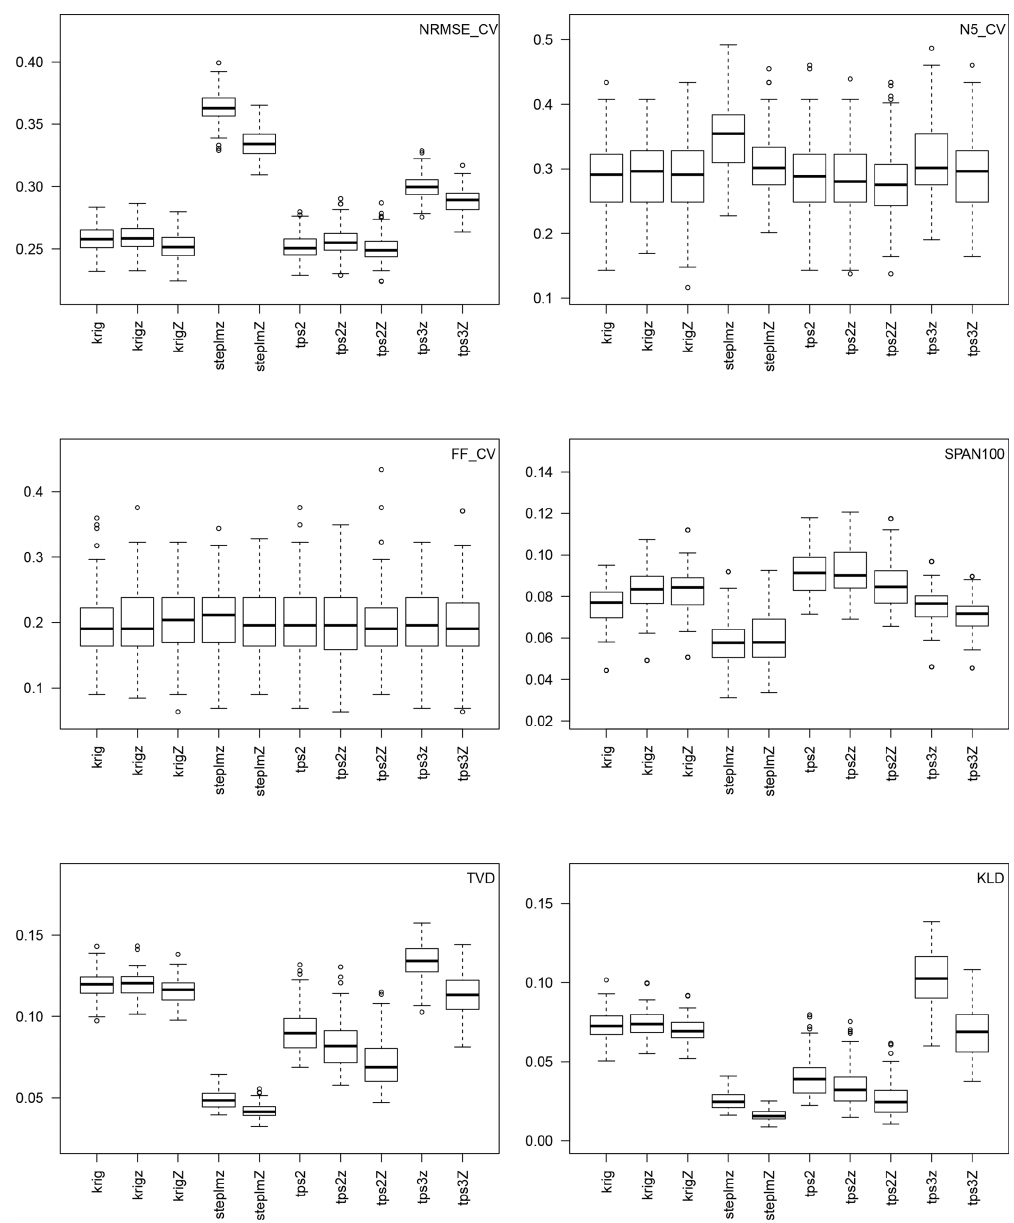
Figure 10. Scores of mapping when G s,k are Gamma distributions with S = 2 and K = 3 whose parameters are interpolated with the mapping models of Table 3. The first two rows show leave-one-out cross-validation scores. Each boxplot contains 200 points. The third row compares interpolations at a given station whether the data of this station are used or not in the interpolation. Each boxplot contains 100